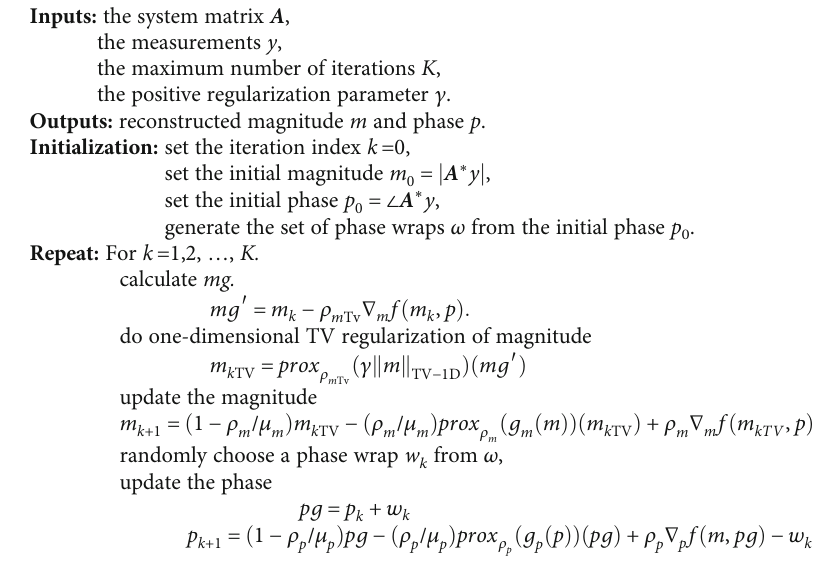
Pseudocode 1: The pseudocode of the modi fi ed phase cycling